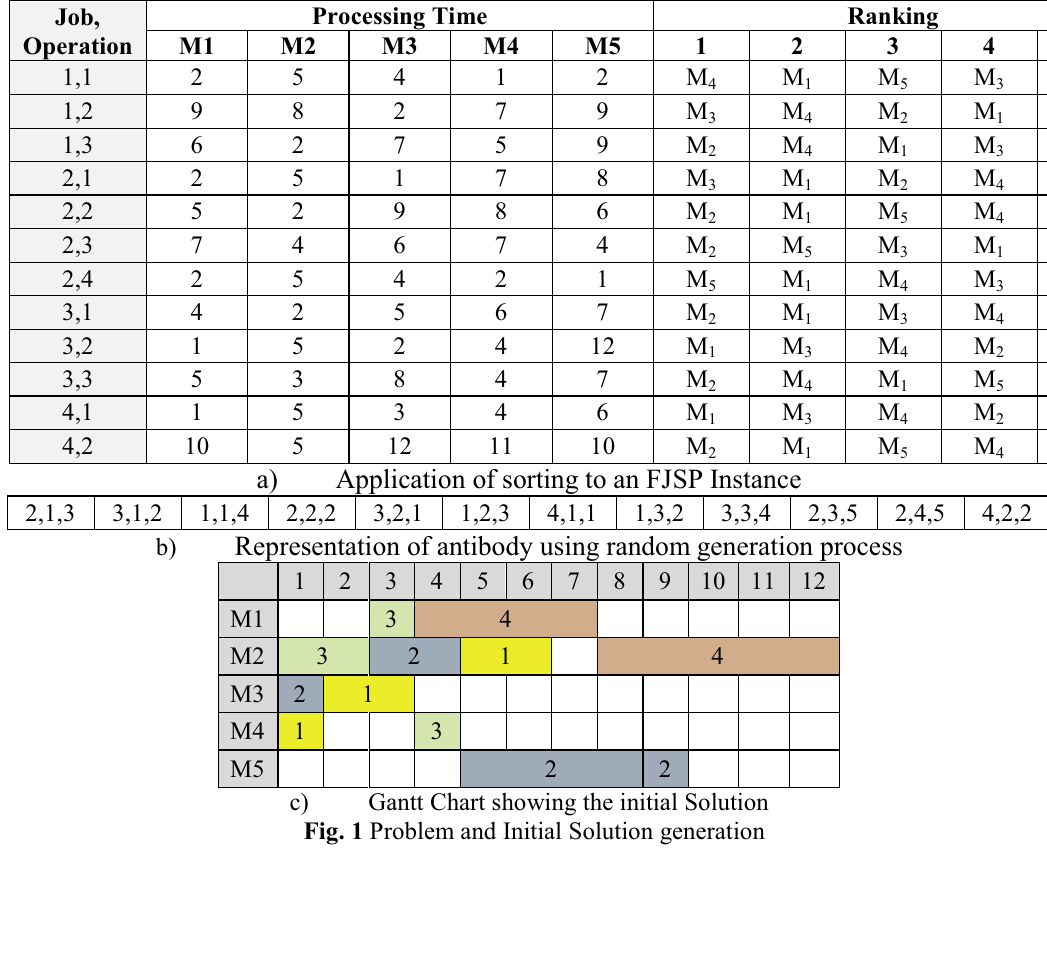
Fig. 1 Problem and Initial Solution